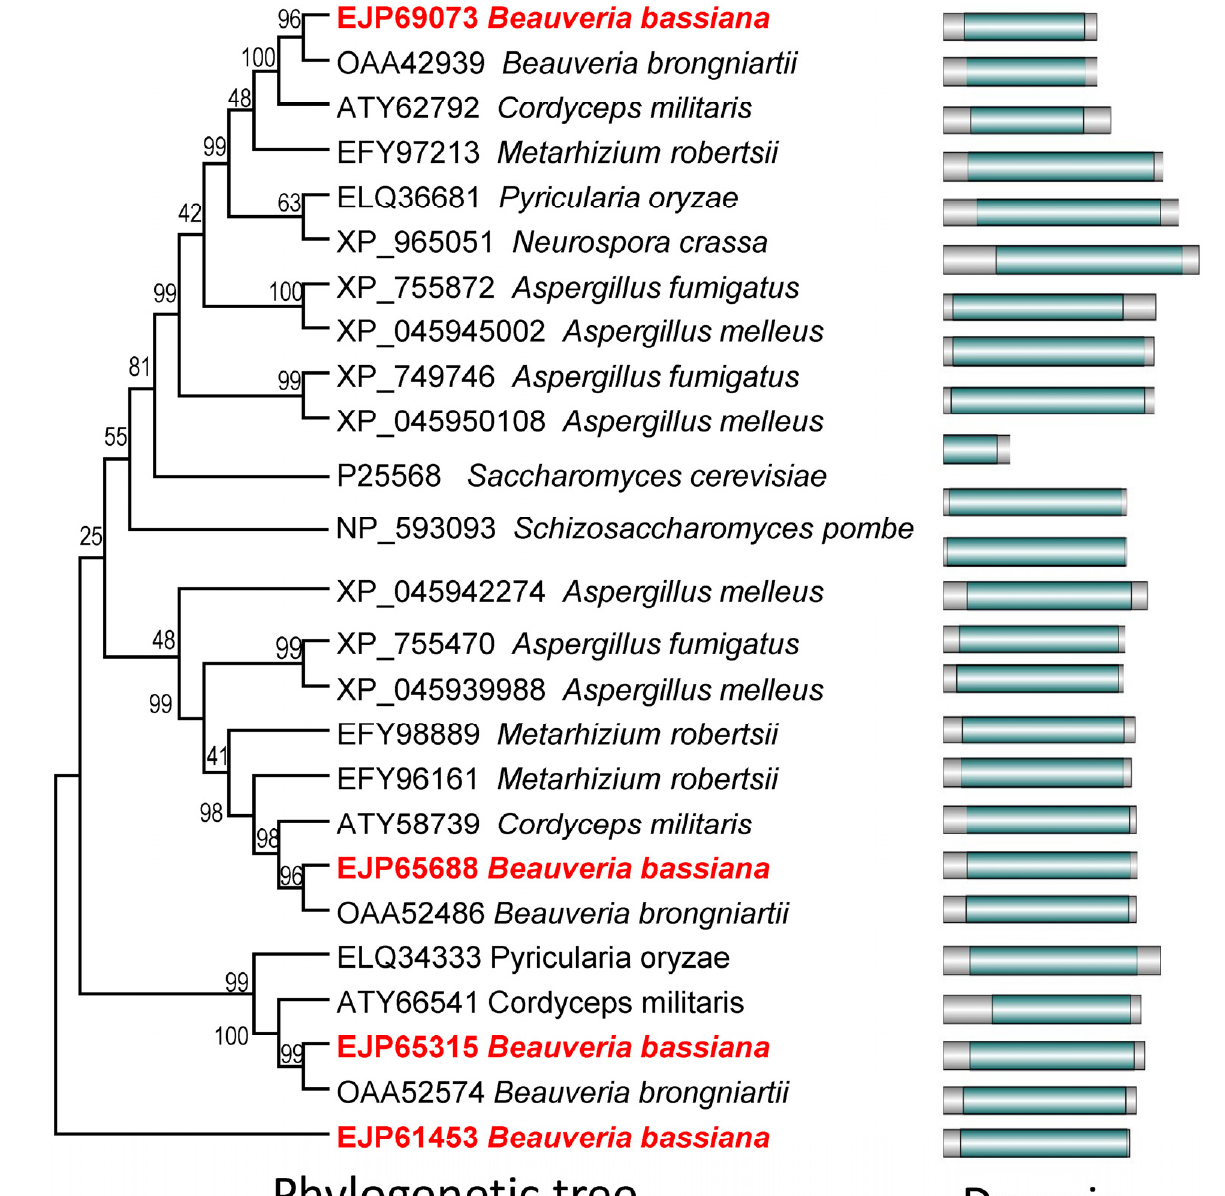
Figure 1. Bioinformatic analyses of Atg22-like proteins. Relationships among the Atg22-like genes were constructed by Neighbour joining method and the bootstrap values from 1000 replicates are shown at nodes. GenBank accession numbers of corresponding genes are followed by fungal species and domain architecture. Yeasts: Saccharomyces cerevisiae , Schizosaccharomyces pombe ; filamentous fungi: Aspergillus melleus , Aspergillus fumigatus Af293 , Cordyceps militaris , Beauveria bassiana ARSEF 2860 , Beauveria brongniartii RCEF 3172 , Metarhizium robertsii ARSEF 23 , Neurospora crassa OR74A , Pyricularia oryzae Y34 . All Atg22-like proteins have an Atg22 domain indicated with dark green. B. bassiana have four Atg22-like proteins, including Atg22A (EJP69073), Atg22B (EJP65688), Atg22C (EJP65315), and Atg22D